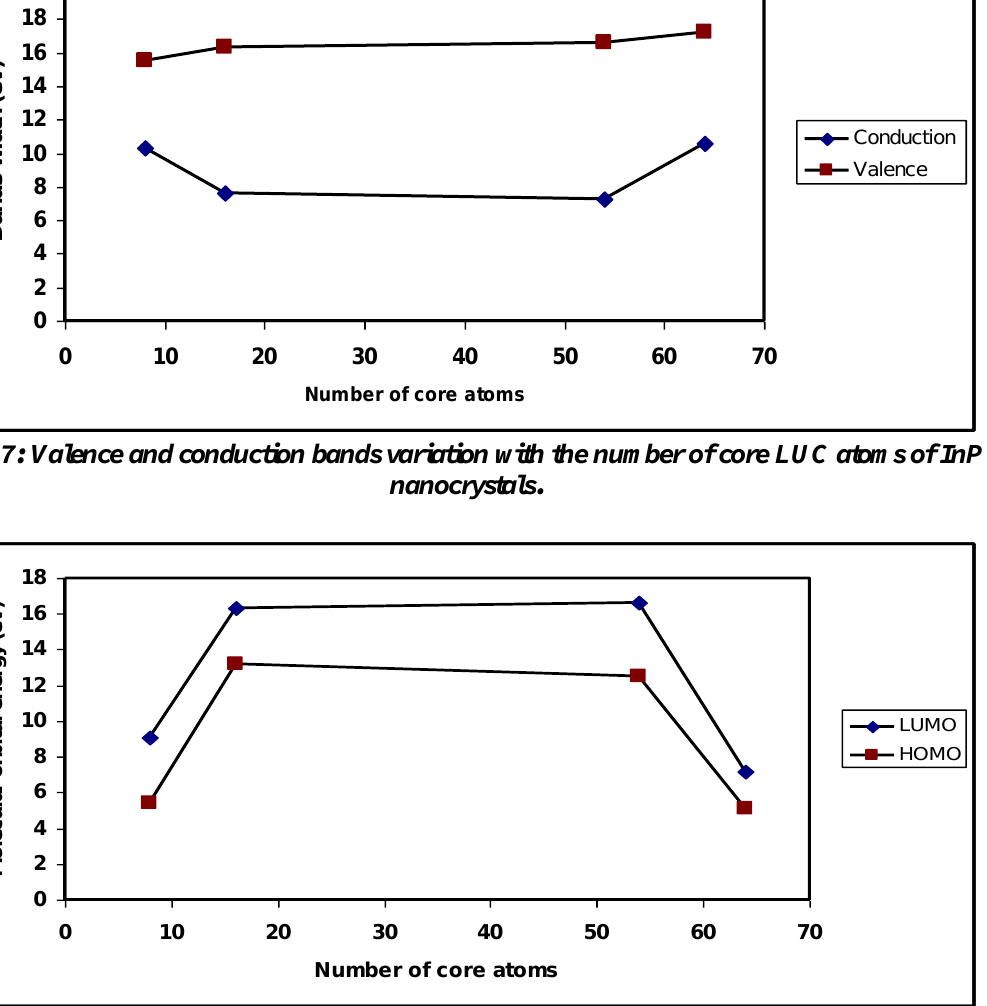
Fig. 8: Energy of the LUMO and HOMO levels variation with the number of core LUC atoms of InP